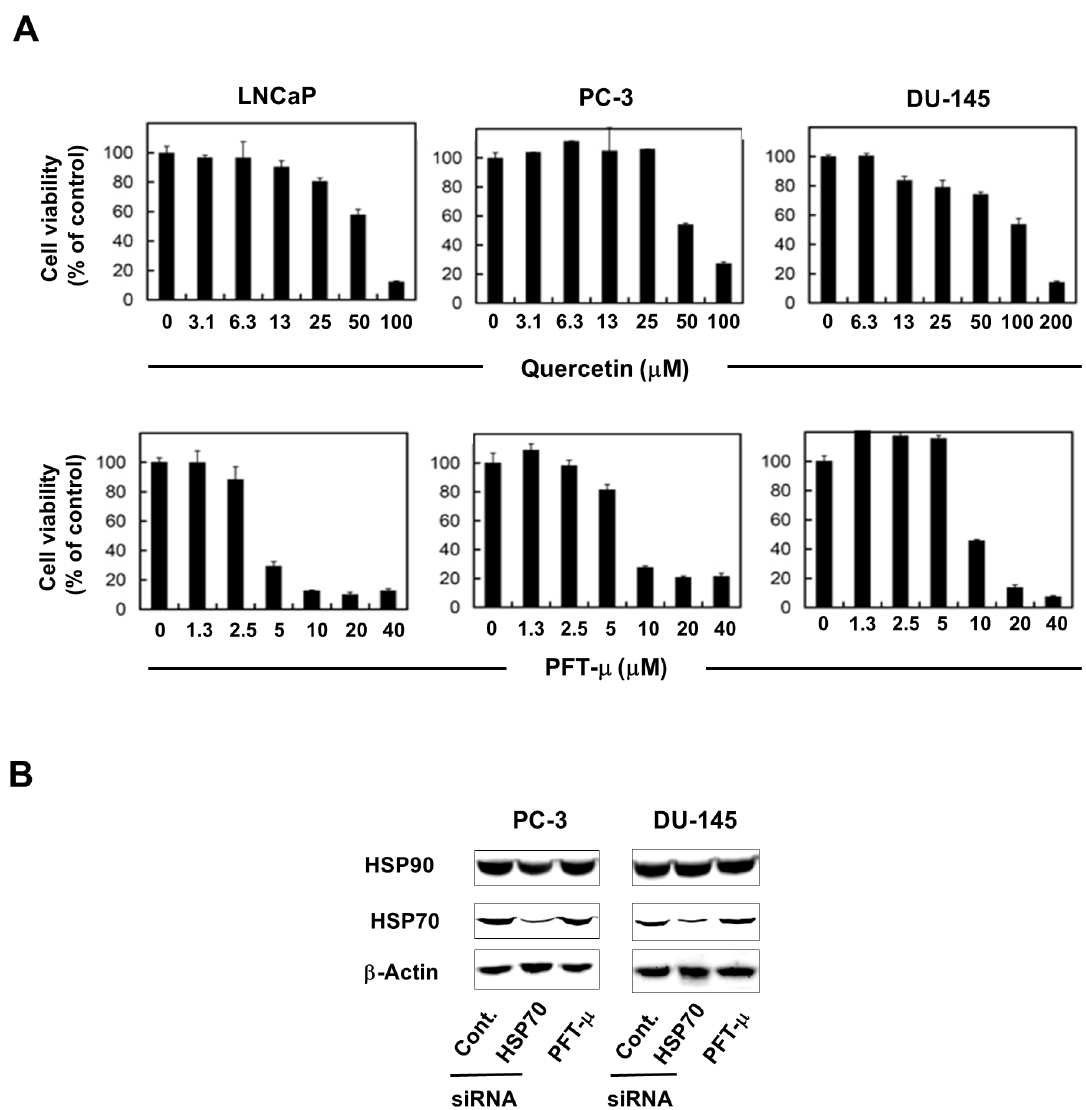
Figure 2. Effects of Quercetin and PFT- m on the viability of prostate cancer cells. ( A ) Three cell lines were cultured with the indicated doses of Quercetin or PFT- m . After 48 h, cell viability (%) was determined using the WST-8 assay. The results are shown as the mean 6 SD of three wells. ( B ) Two days after transfection of HSP70 siRNA or control siRNA, the expression of HSP90 and HSP70 was assessed by immunoblot. The expression of these HSPs was also examined after the treatment with PFT- m (5 m M). b -Actin was used as a control.